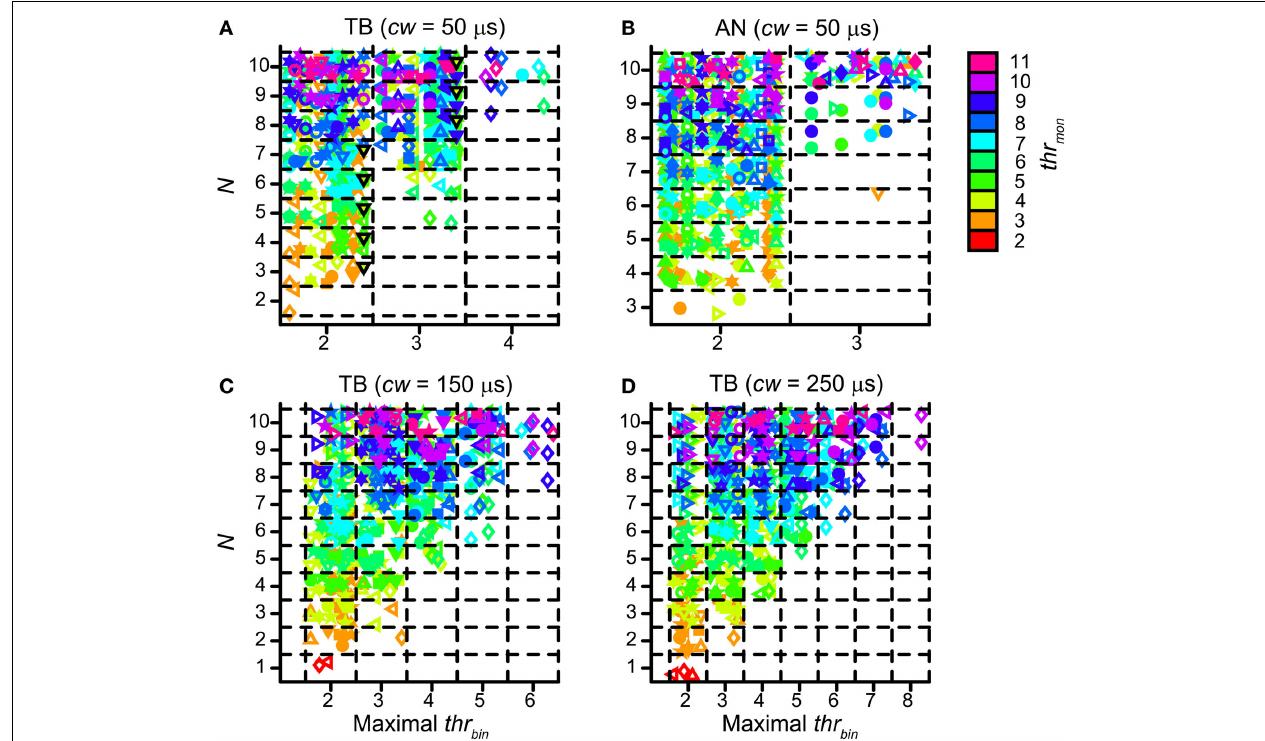
FIGURE 12 | Maximalvaluesfor thr bin ,fordifferentvaluesof N and thr mon .(A) TBfibers( n = 12), cw = 50 μ s.Blacktrianglesfilledwithgreenindicatedataset in Figure 11 . (B) ANfibers( n = 13), cw = 50 μ s. (C) TBfibers( n = 13), cw = 150 μ s. (D) TBfibers( n = 13), cw = 250 μ